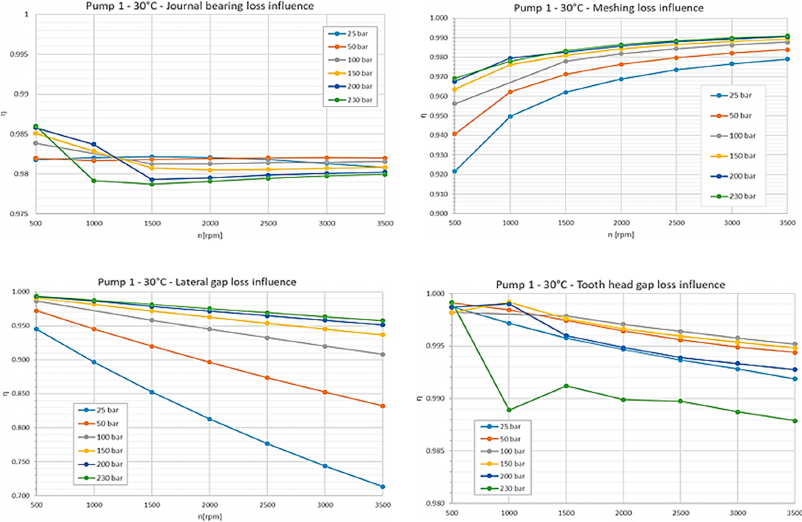
Figure 9. Relative errors on the calculation of the mechanical e ffi ciency of pump 2 for di ff erent operating conditions and fluid temperature: ( a ) 50 ◦ C and h 0 = 5 µ m; ( b ) 30 ◦ C and h 0 = 10 µ m.